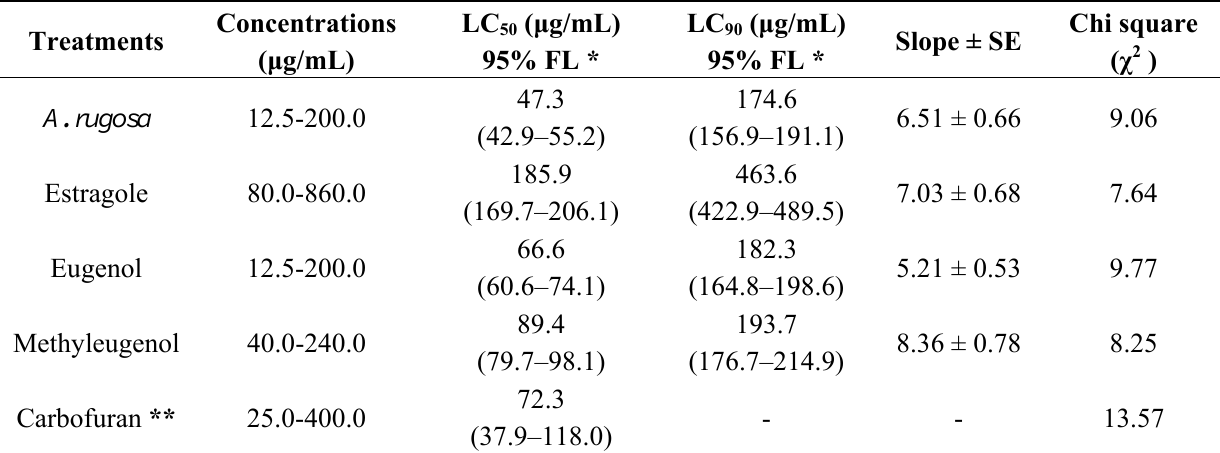
Table 2. Nematicidal activity of the essential oil of Agastache rugosa aerial parts and its three main components against Meloidogyne incognita